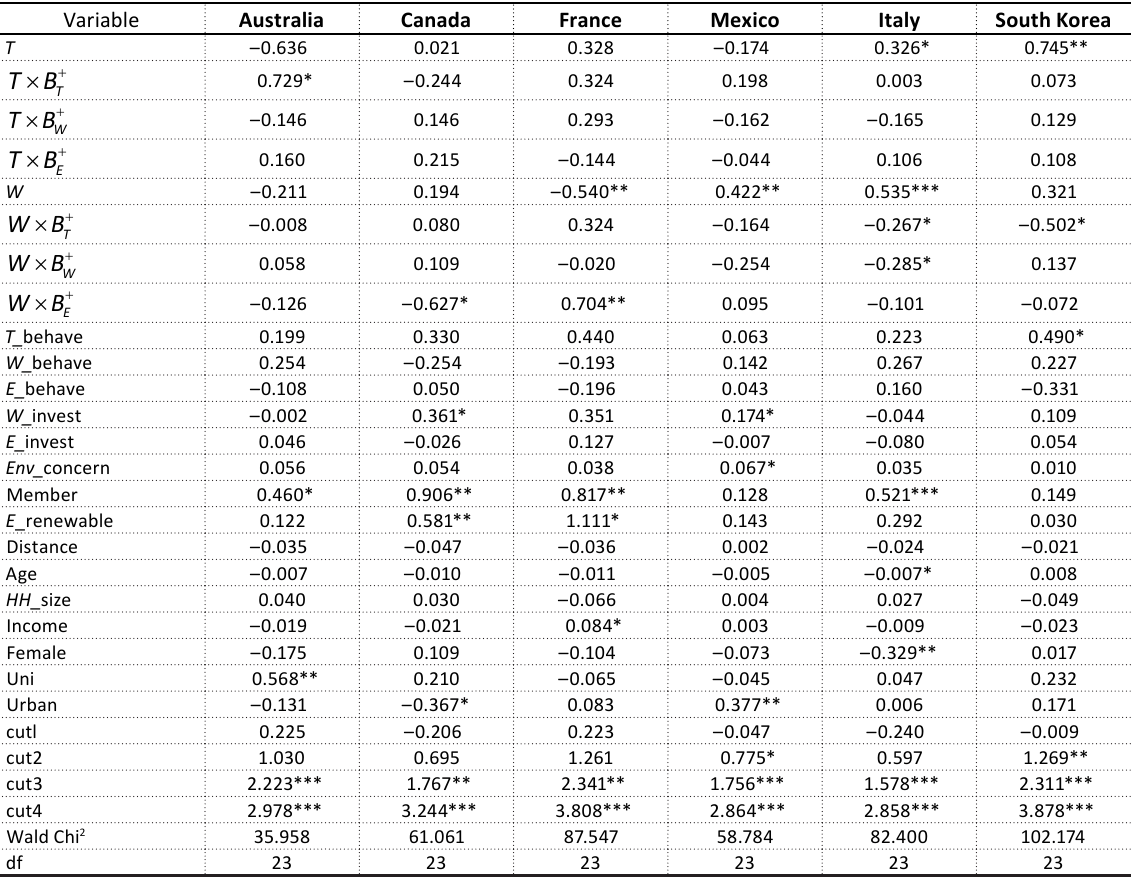
Table B5. Countrvwise parameter estimates of ordered probit with random effects Variable